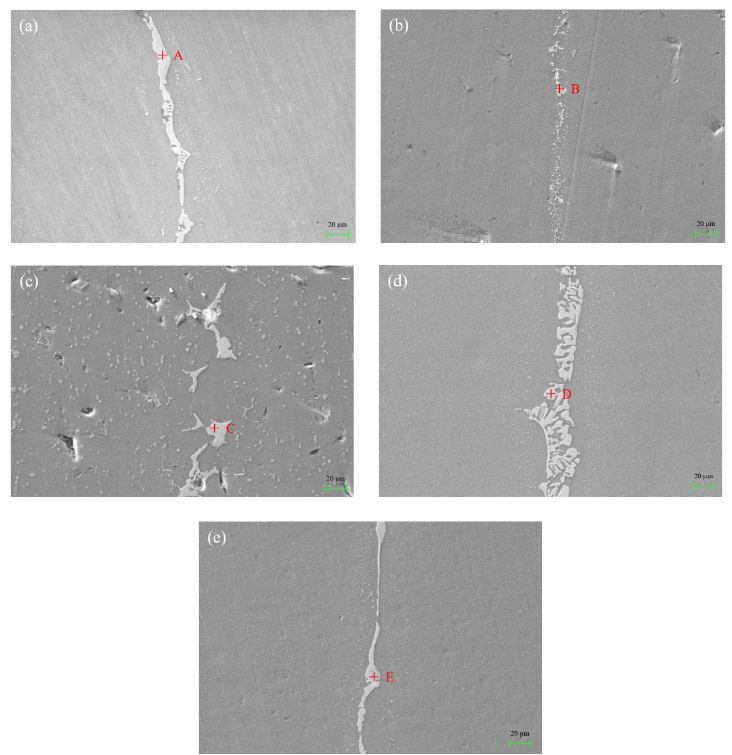
Figure 8. SEM image of the joint brazed with different temperature and dwell time: ( a ) 565 °C and 15 min; ( b ) 570 °C and 15 min; ( c ) 575 °C and 15 min; ( d ) 575 °C and 20 min; ( e ) 575 °C and 25 min. Table 3. Chemical compositions (at.%) of points marked in Figure 8.